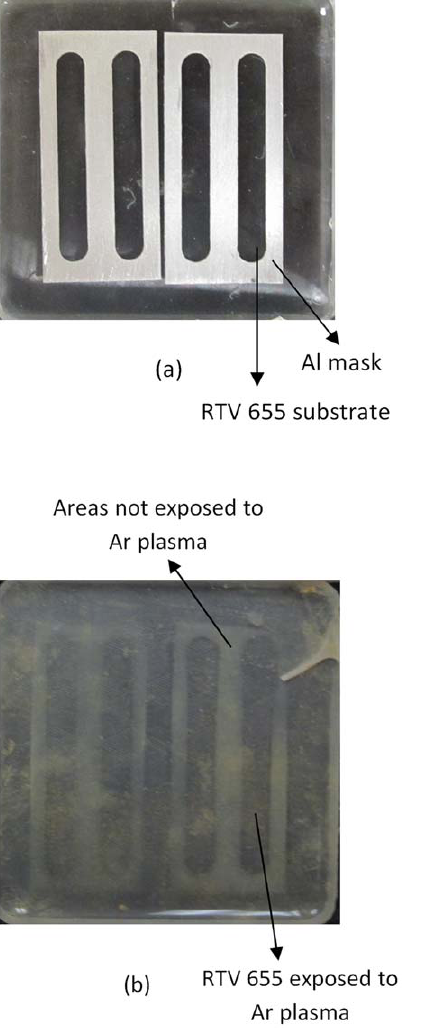
Figure 5. Ar plasma exposure of RTV 655 with mask. Argon plasma exposure of RTV 655 sample with a patterned mask (a) followed by the dust chamber exposure step. The mask pattern can be seen clearly (b) highlighting the impact of the Ar plasma treatment step on the dust adhesion behavior of the polymer.